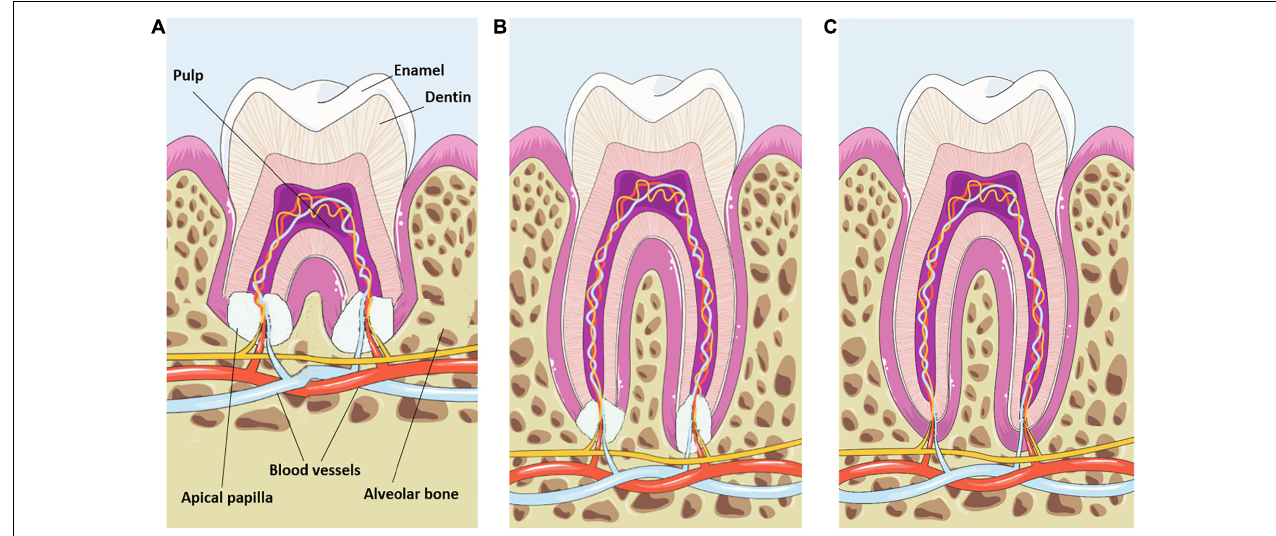
FIGURE 1 | Schematic representation of apical papilla-induced root maturation. (A) The apical papilla is located at the growing part of the maturing dental root. Note the different components of the tooth and the dental vasculature entering the apical papilla and pulp tissue. (B) During root elongation the apical papilla progressively decreases in size. (C) Fully mature roots are associated with a complete loss of the apical papilla tissue. This image was created using Servier Medical Art, licensed under a Creative Common Attribution 3.0 Generic License, available online at